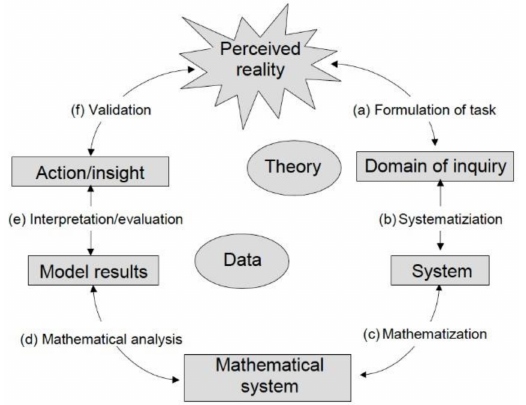
Figure 1. A mathematical modeling process description with six sub-processes ([20], p.